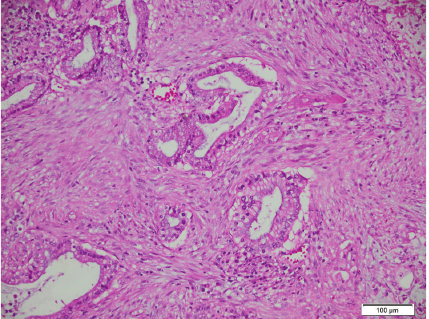
Figure 8: Histopathology of areas with gland formation (adenocar- cinoma).